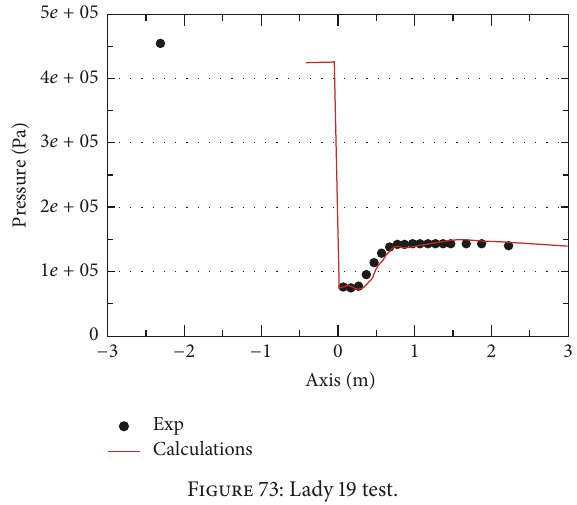
Figure 73: Lady 19 test.